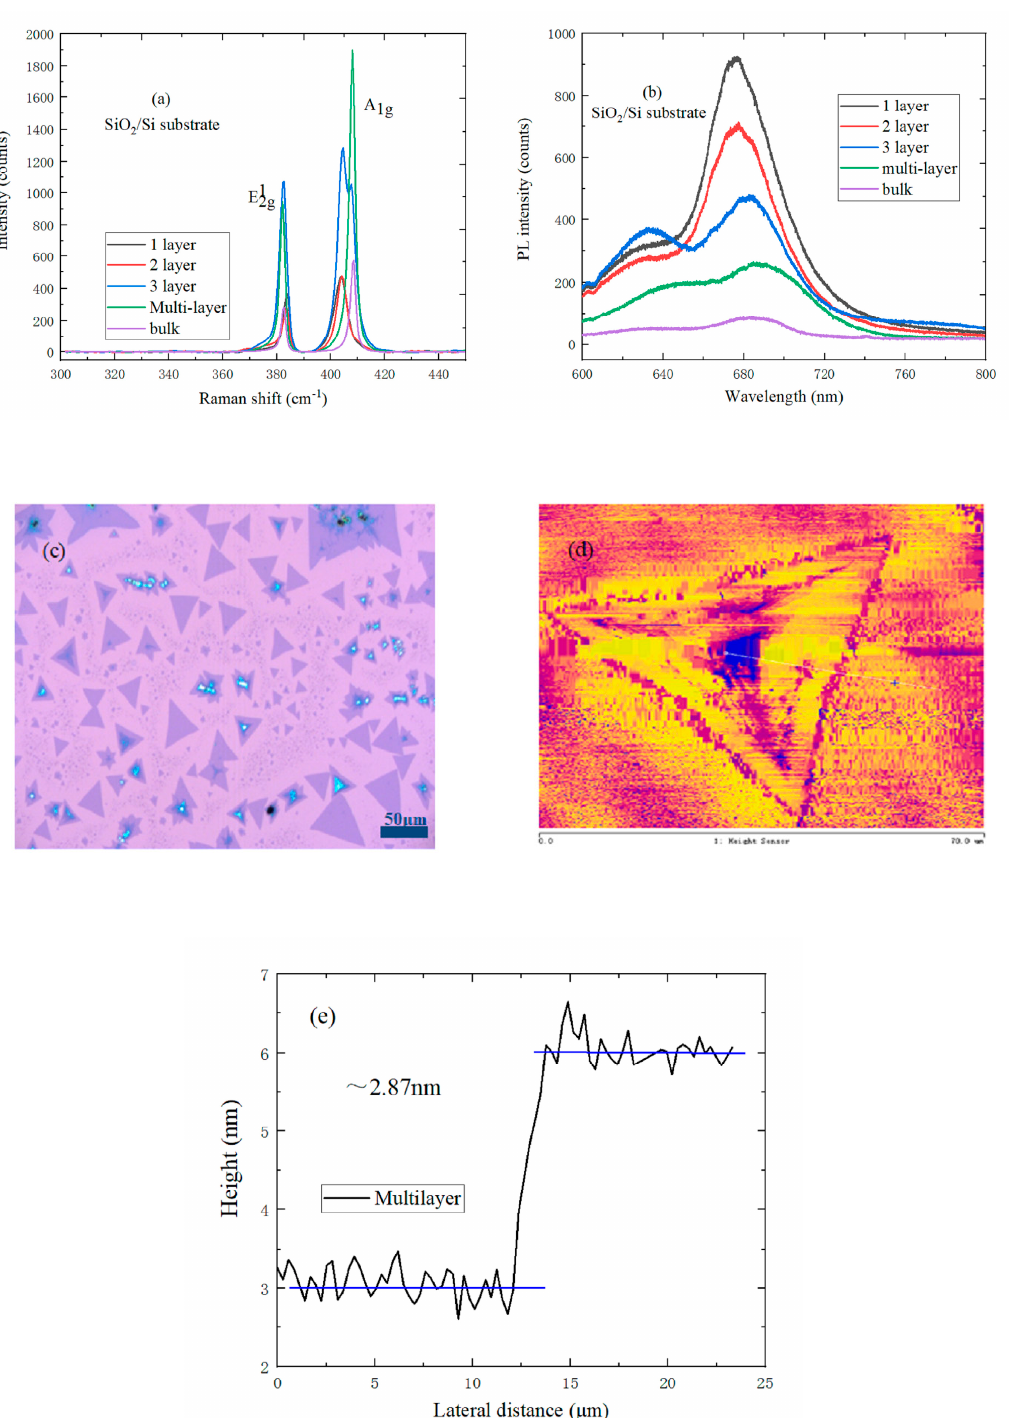
Figure 5. ( a ) Raman spectrum of MoS 2 with di ff erent layers on a SiO 2 / Si substrate; ( b ) PL spectrum of MoS 2 with di ff erent layers on a SiO 2 / Si substrate; ( c ) Optical micrograph of MoS 2 with di ff erent layers on a SiO 2 / Si substrate; ( d ) AFM morphology of multilayer MoS 2 on a SiO 2 / Si substrate; ( e ) Height profile of multilayer MoS 2 on a SiO 2 / Si substrate.